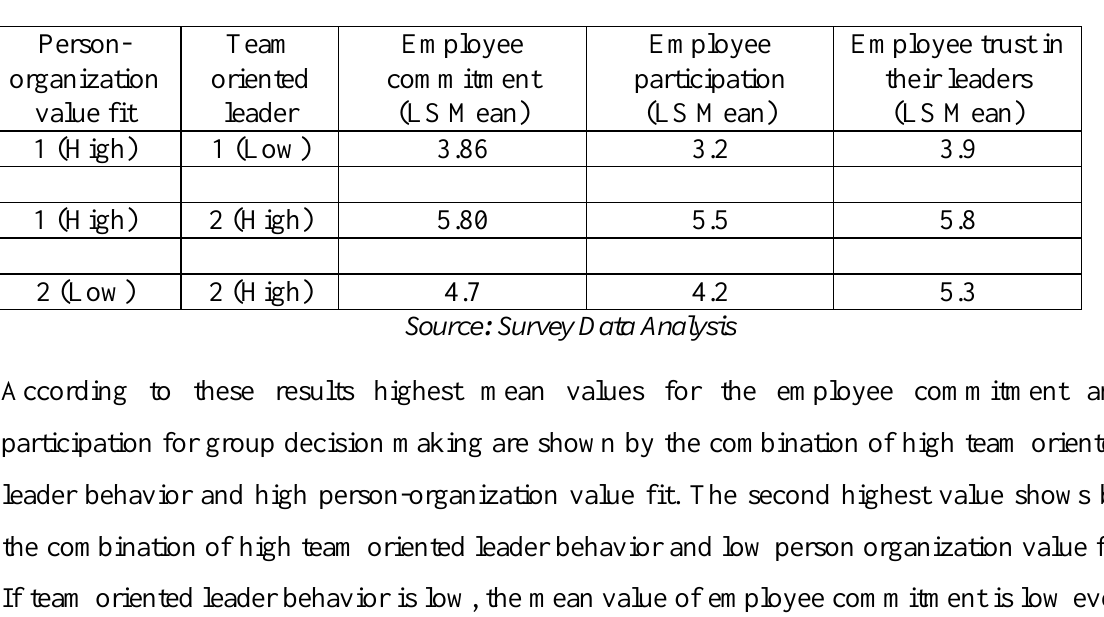
Table 5: Least Squares Means for Mean